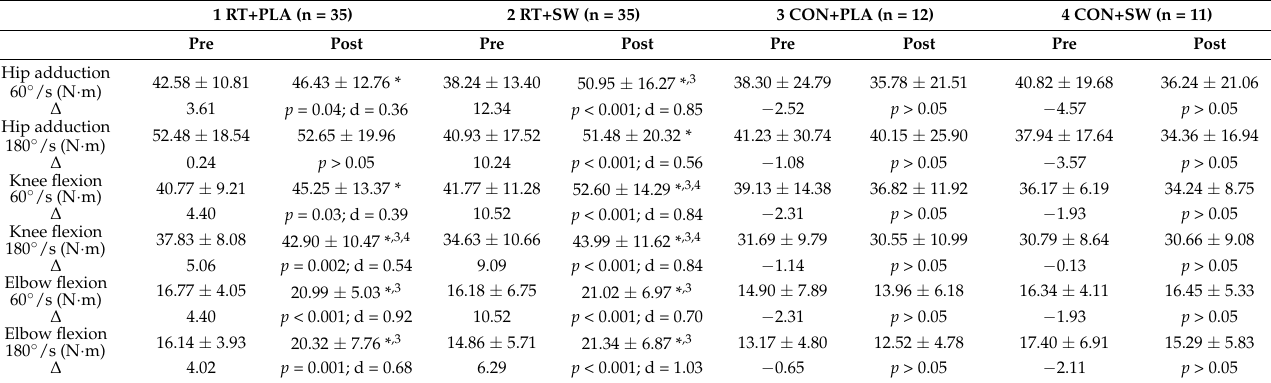
Table 3. Isokinetic neuromuscular strength.